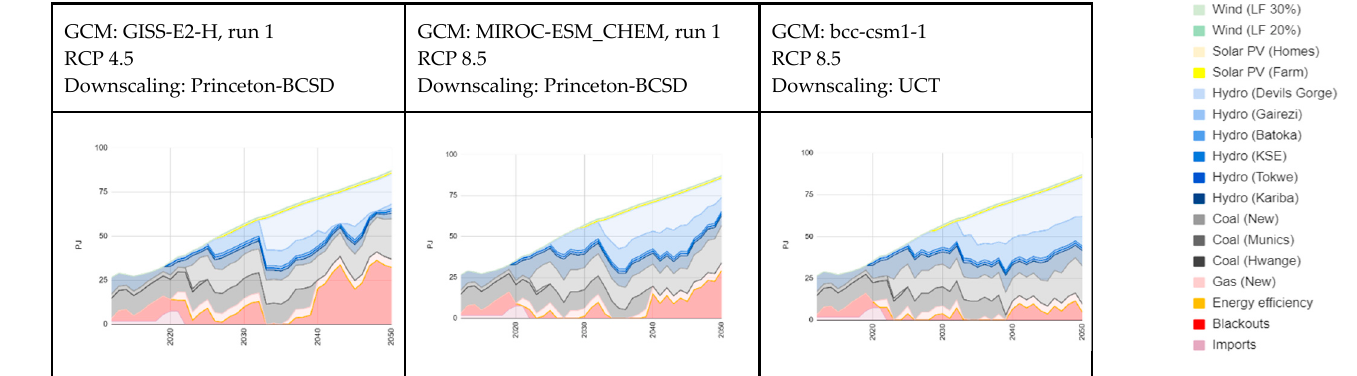
Figure 3. Study Results—Electricity production in the NDC Scenario under selected future climates (Petajoules).